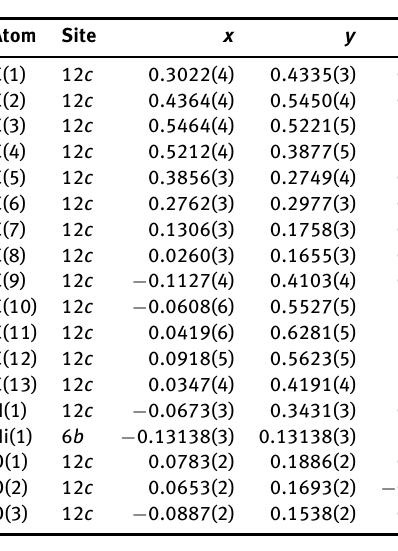
Table 3: Atomic displacement parameters (Å 2